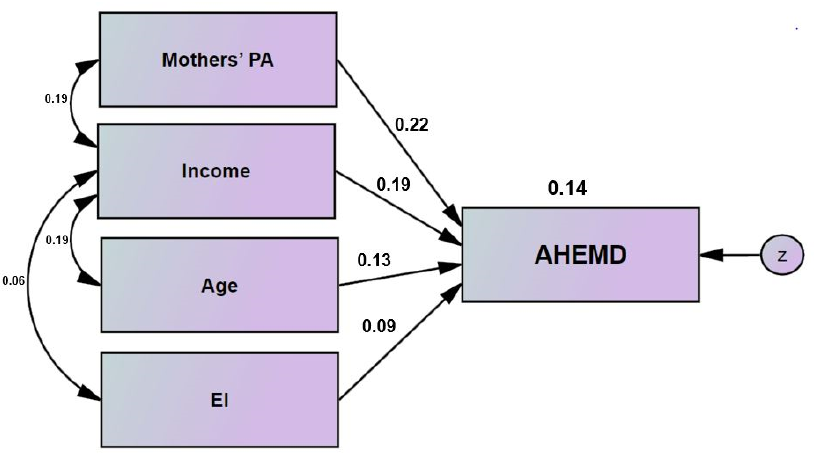
Figure 1. Final regression model. Table 5. Model fit indices.